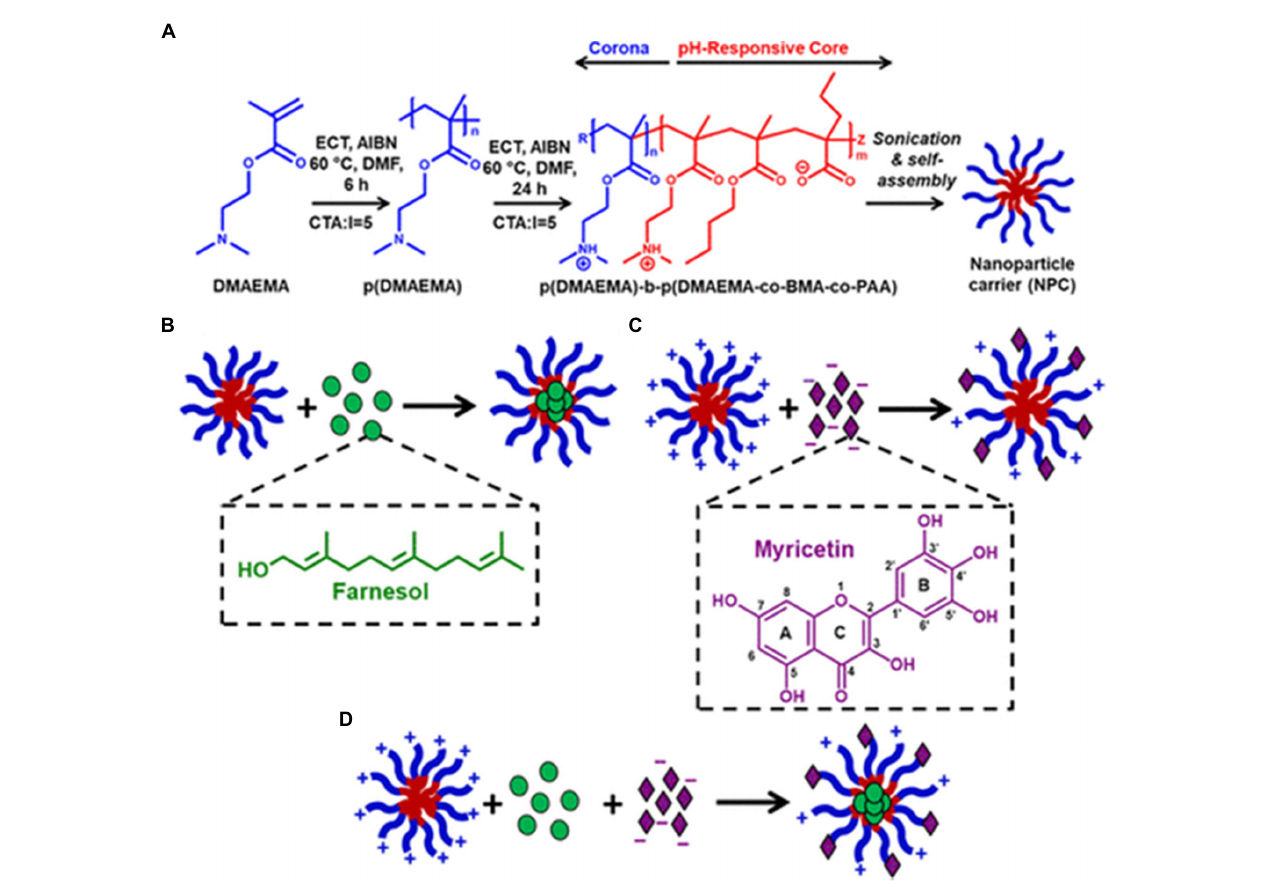
FIGURE 7 Cationic NPCs hypothesized to coload hydrophobic drugs and flavonoids using different mechanisms. (A) Scheme showing the cationic NPC polymer synthesis process, diblock composition, and micelle self-assembly in aqueous conditions; (B) Cartoon illustrating the known mechanism of hydrophobic drug (e.g., farnesol) loading within the NPC hydrophobic core; (C) Cartoon illustrating the hypothesized mechanism of flavonoid (e.g., myricetin) loading with cationic NPCs via an electrostatic interaction; (D) Cartoon illustrating the proposed mechanism of coloading NPCs with farnesol and myricetin. (A, B) Reproduced with permission from